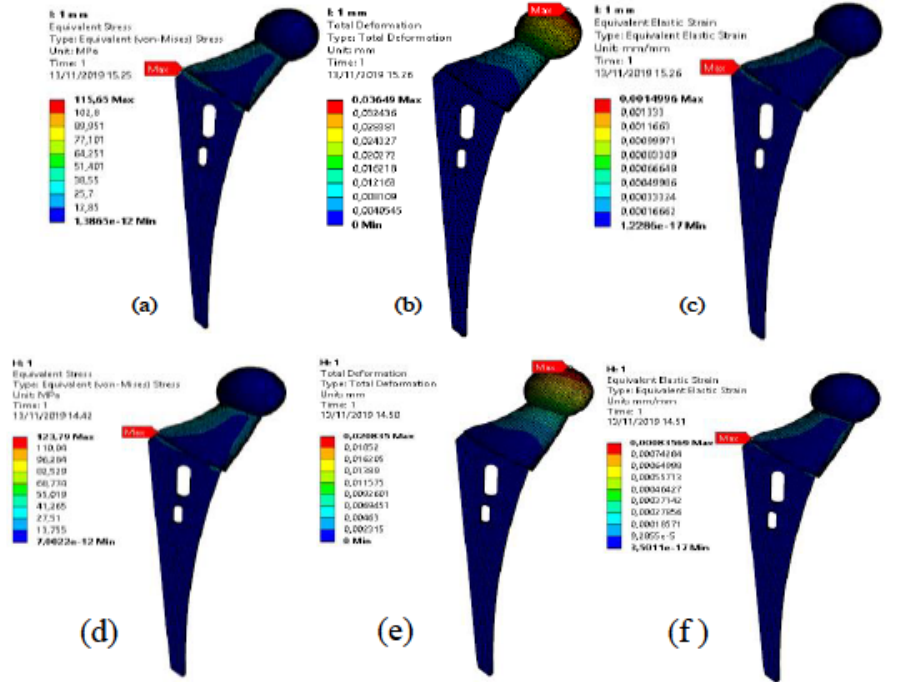
Figure 10: For element size 1 mm on Ti-6Al-4V (a) Stress (von misses), (b) deformation, (c) strain (von misses) and on SS 316 L 4V (d) Stress (von misses), (e) deformation, (f) strain (von misses)